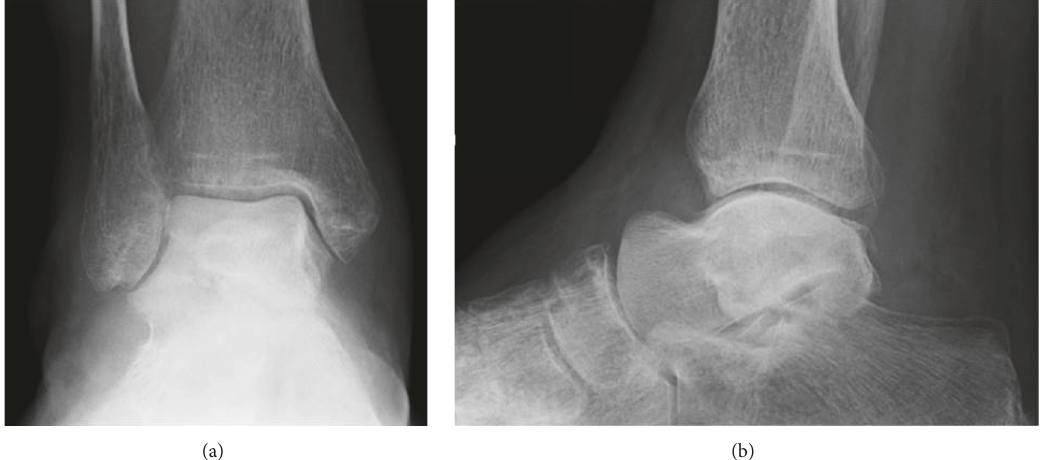
Figure 6: Preoperative radiographs showing sclerotic change and collapse of the talar body in anteroposterior (a) and lateral (b)